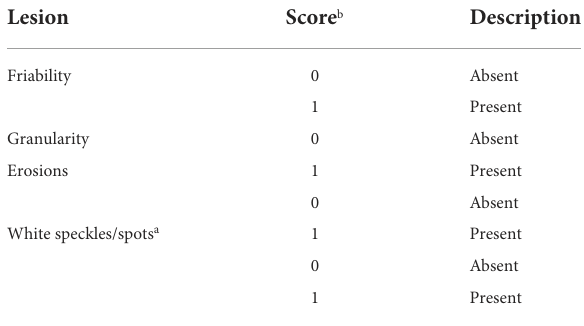
TABLE 1 Simple endoscopic score for canine chronic enteropathy [modified from (151)].